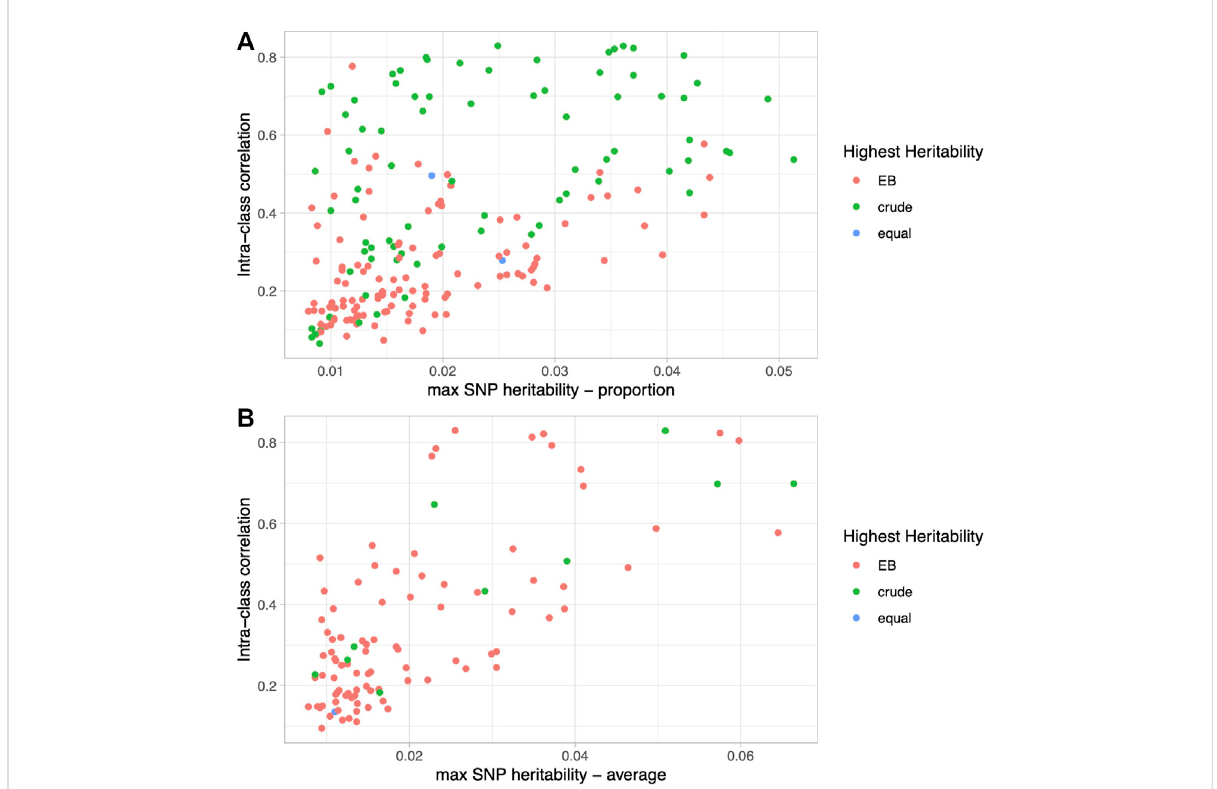
FIGURE 3 Relationship between phenotype reliability and heritability. Scatter plots of intra-class correlation ( y -axis) versus SNP heritability estimates ( x -axis) colored by the method (EB, crude, or equal) that led to the higher heritability for proportion phenotypes (A) and average phenotypes (B)